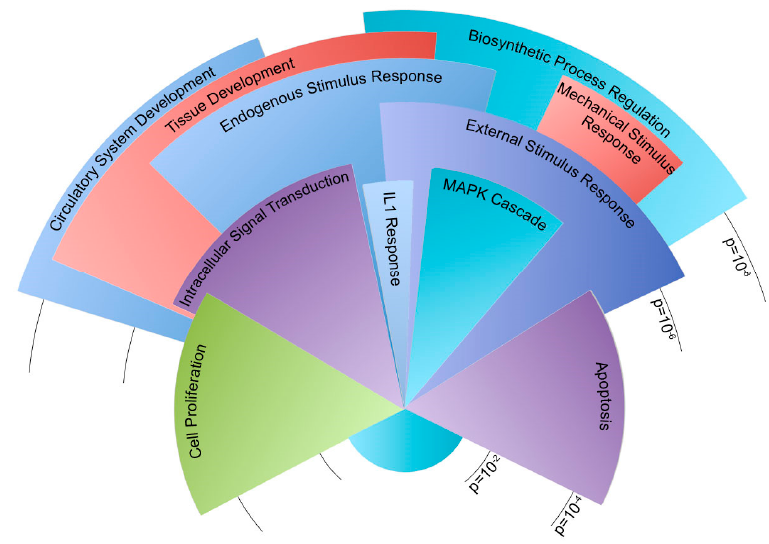
Figure 4. Congruent genes dysregulated in Bmpr2 R899X endothelial cells after 24 h of perfusion. Pie chart shows relative number of genes in statistically dysregulated gene ontology groups. Arc length of the gene ontology groups corresponds to the number of genes present in each group. Radius length corresponds to significance, where the longest categories were significantly dysregulated at ~ p < 1 × 10 − 8 and the shortest categories were dysregulated at p < 1 × 10 − 3 . Please see the Supplementary Materials for a table of these findings.